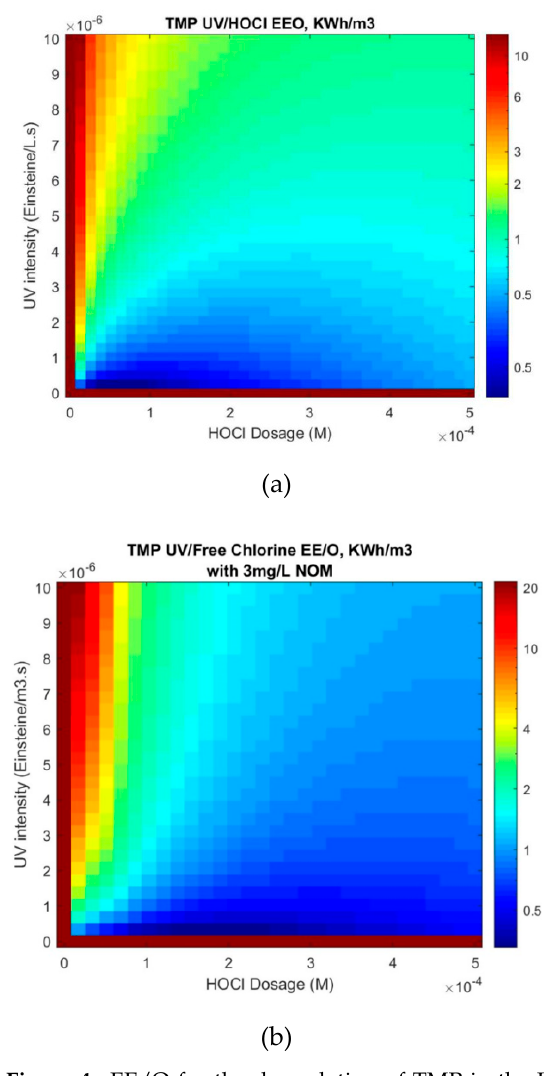
Figure 4. EE/O for the degradation of TMP in the UV/free chlorine process. ( a ) EE/O for the degradation of TMP when NOM was not present; ( b ) EE/O for the degradation of TMP when NOM was present. Conditions: [TMP] 0 = 0.01 mM, [NOM] = 3 mg/L, pH 7.2.